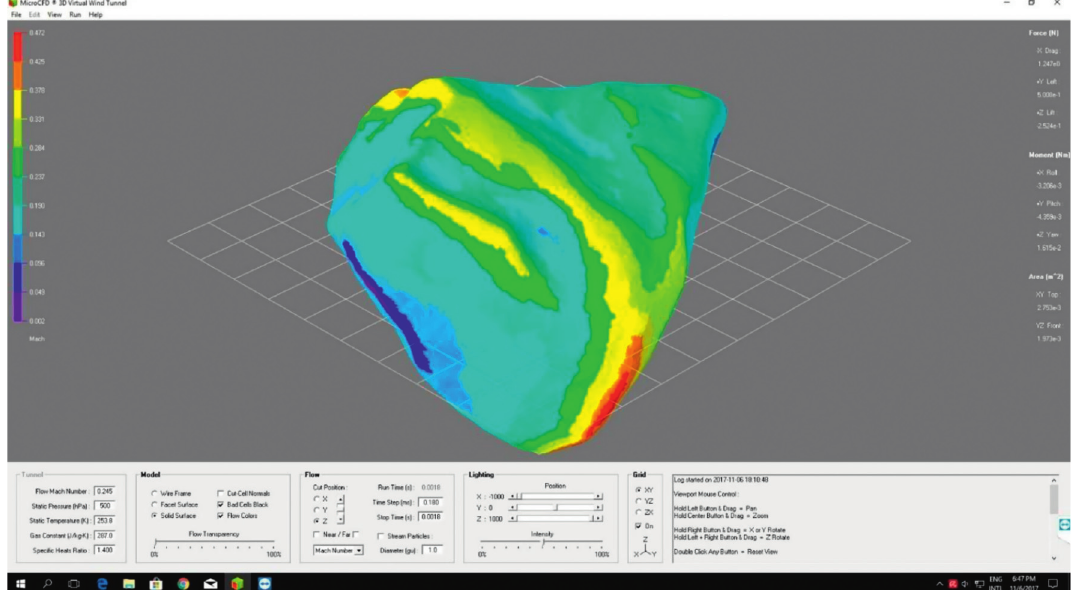
Figure 2: The MicroCFD (Computing Fluid Dynamics) software interface, which simulates conditions of supersonic flow around the body in virtual wind tunnel (http://microcfd.com/index.htm). Graphical and numerical representation of the results of drag force and moment of force for a 3D model of a real-shaped body